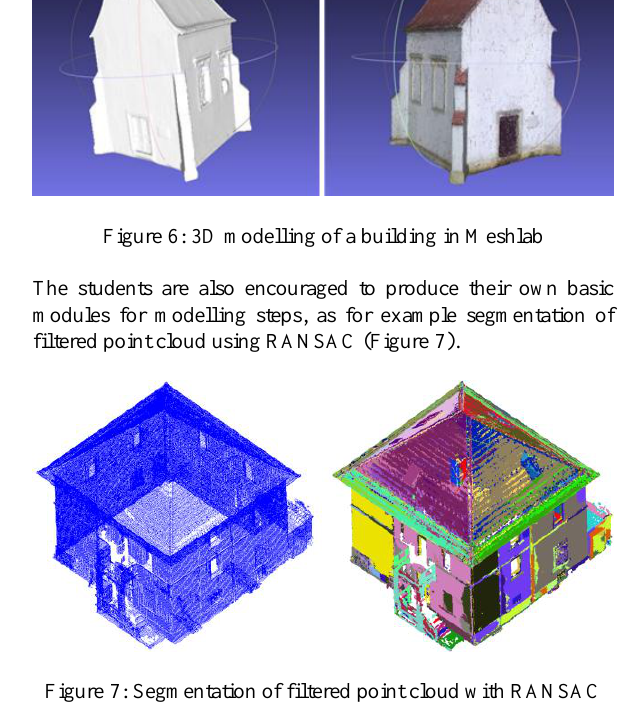
Figure 7: Segmentation of filtered point cloud with RANSAC